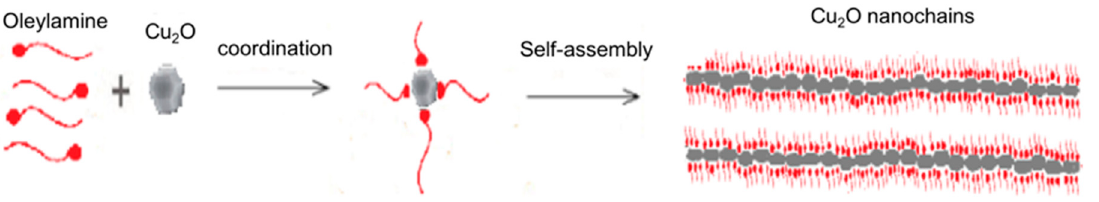
Figure 8. The schematic diagram of the formation mechanism of Cu 2 O nanochains.